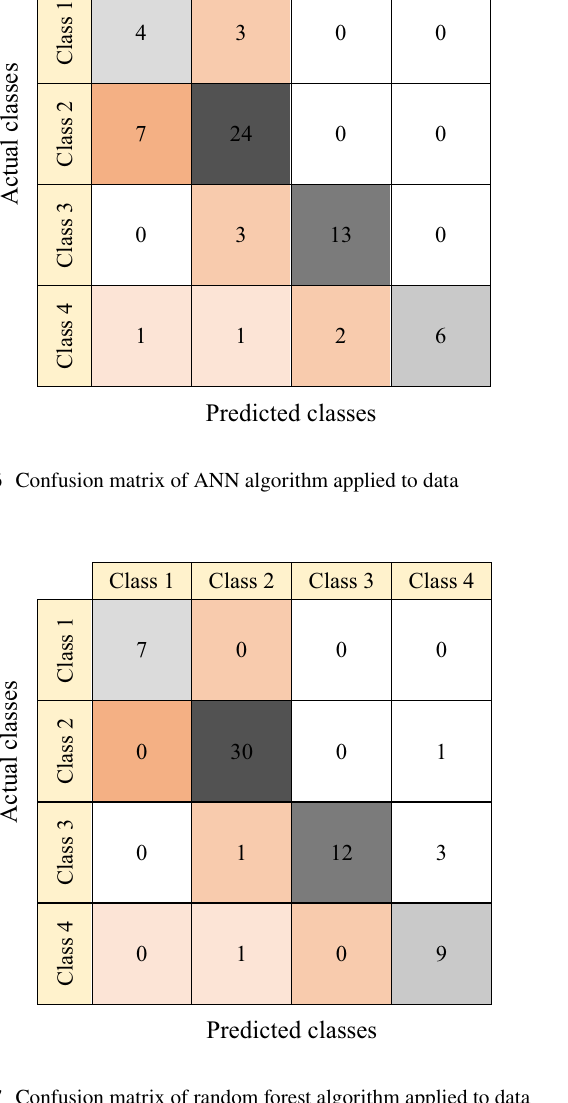
Fig. 17 Confusion matrix of random forest algorithm applied to data